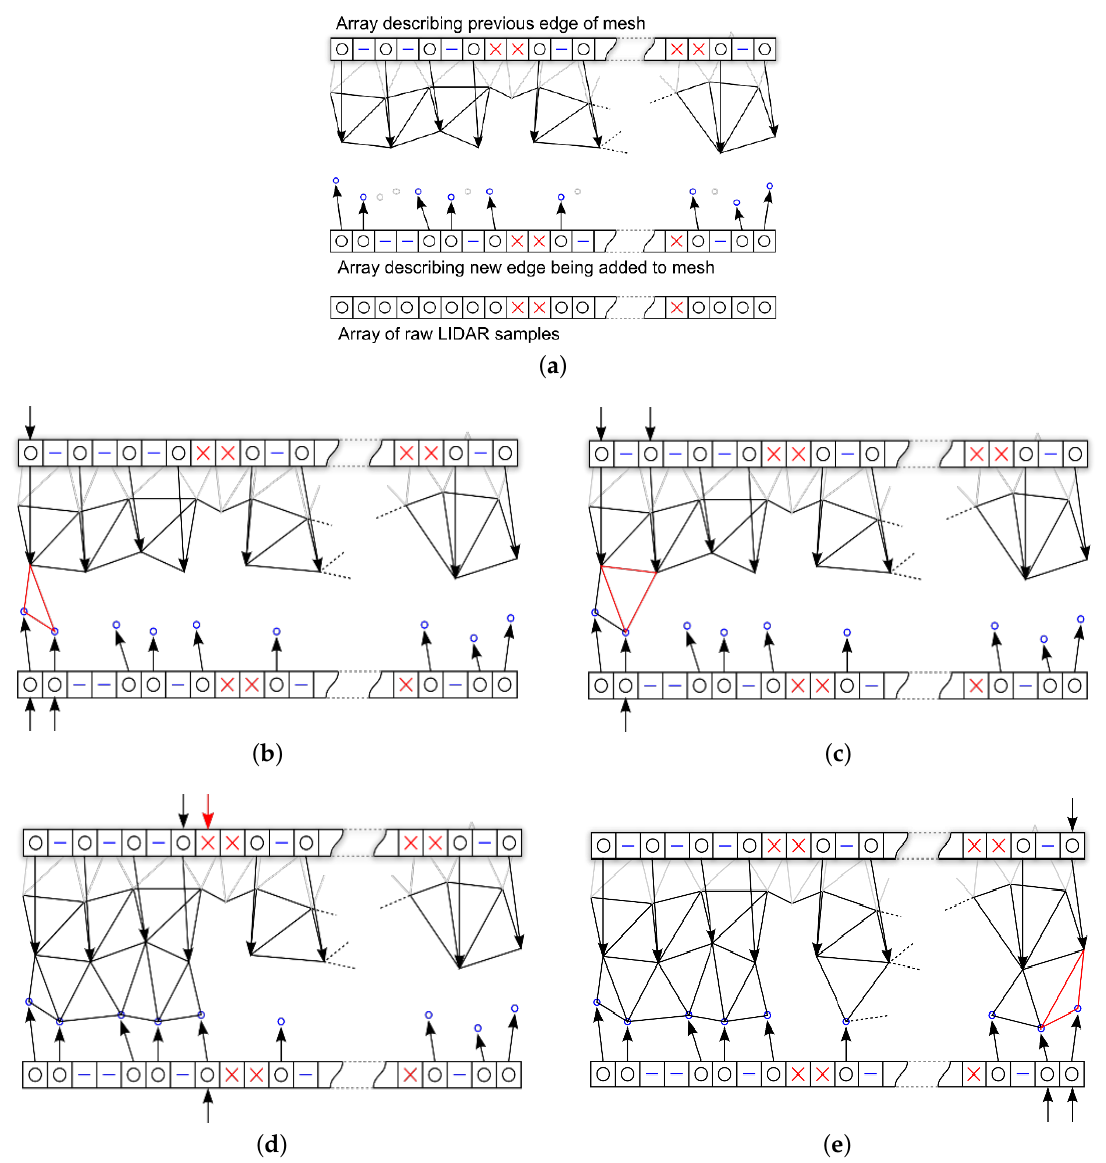
Figure 17. Method used to reduce the resolution of the line of raw LIDAR points and adding to the mesh creating a new edge array ( a ) and process of triangulating a stripe of reduced resolution LIDAR data into the mesh ( b – e